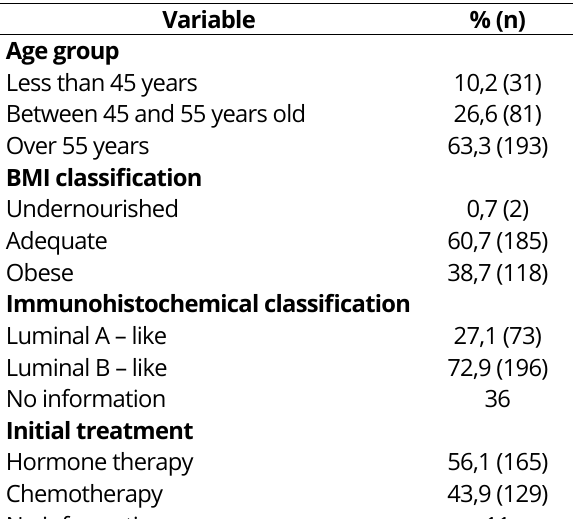
Table 1. Clinical and demographic characteristics of the patients evaluated in this